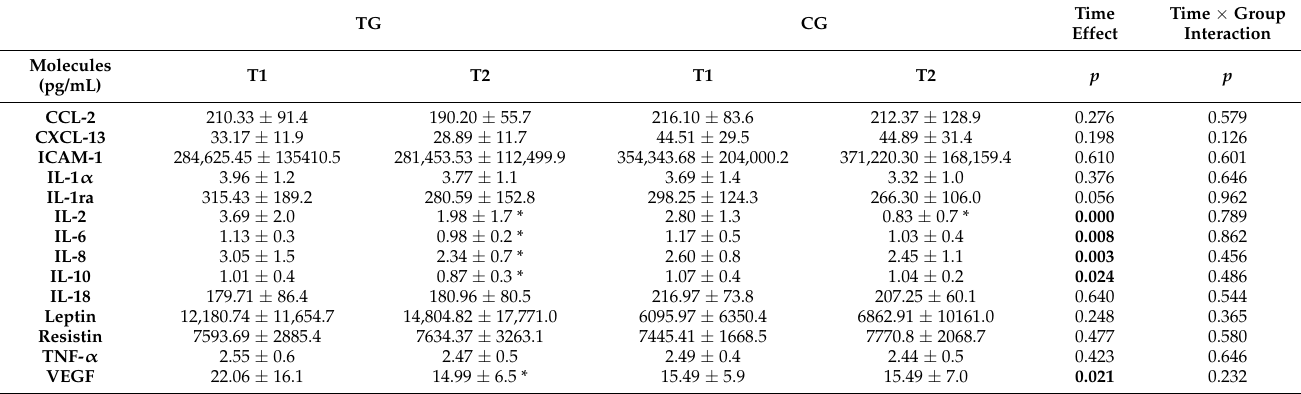
× Group Interaction